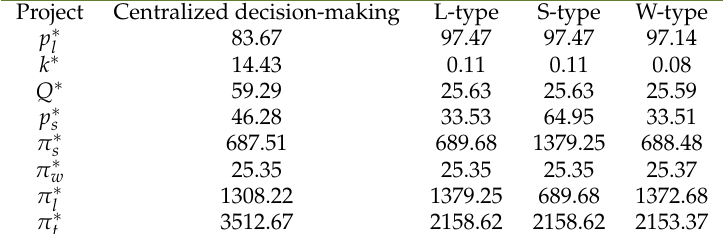
Table 3. Numerical simulation results of different decision models in enterprise supply chain